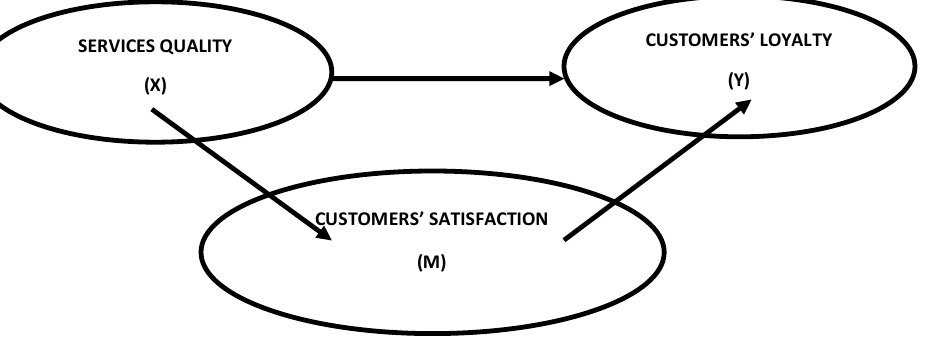
Figure 2: The Path Model for the Relationship among Services Quality, Customers’ Loyalty anf Customers’ Satisfaction